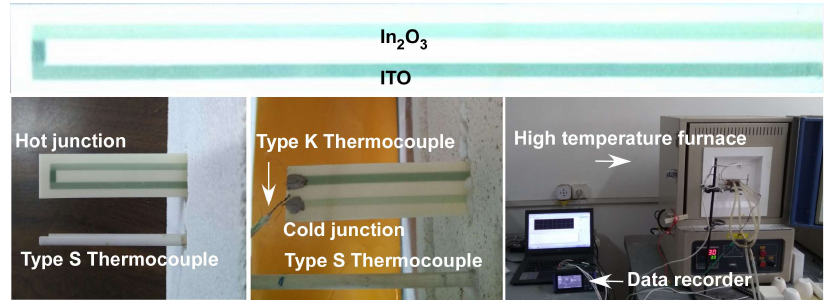
Figure 1. The In 2 O 3 /ITO thermocouple and its measuring system.